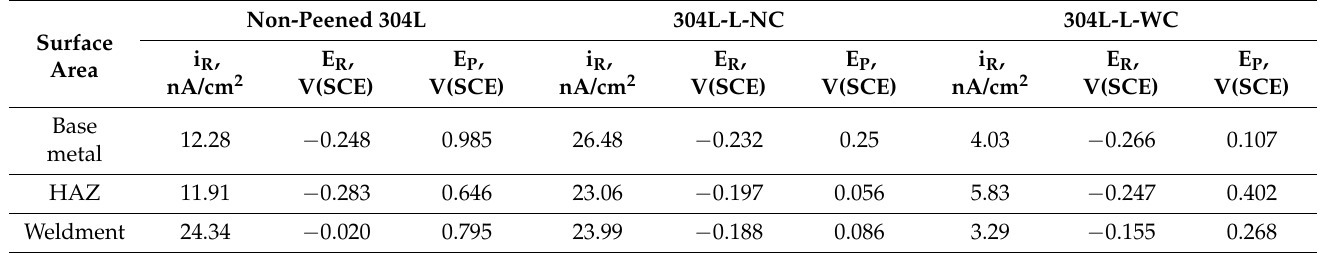
Table 6. The corrosion factors of the surface of 304L stainless steel obtained from Tafel extrapolation.